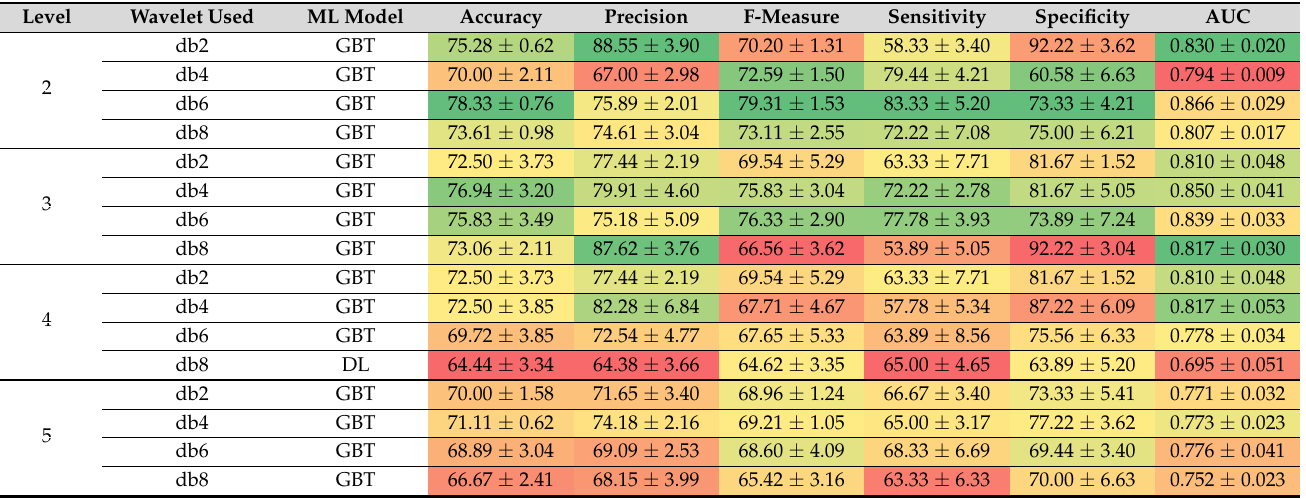
cessing of the ECG signals at different decomposition levels. of the ECG signals at different decomposition